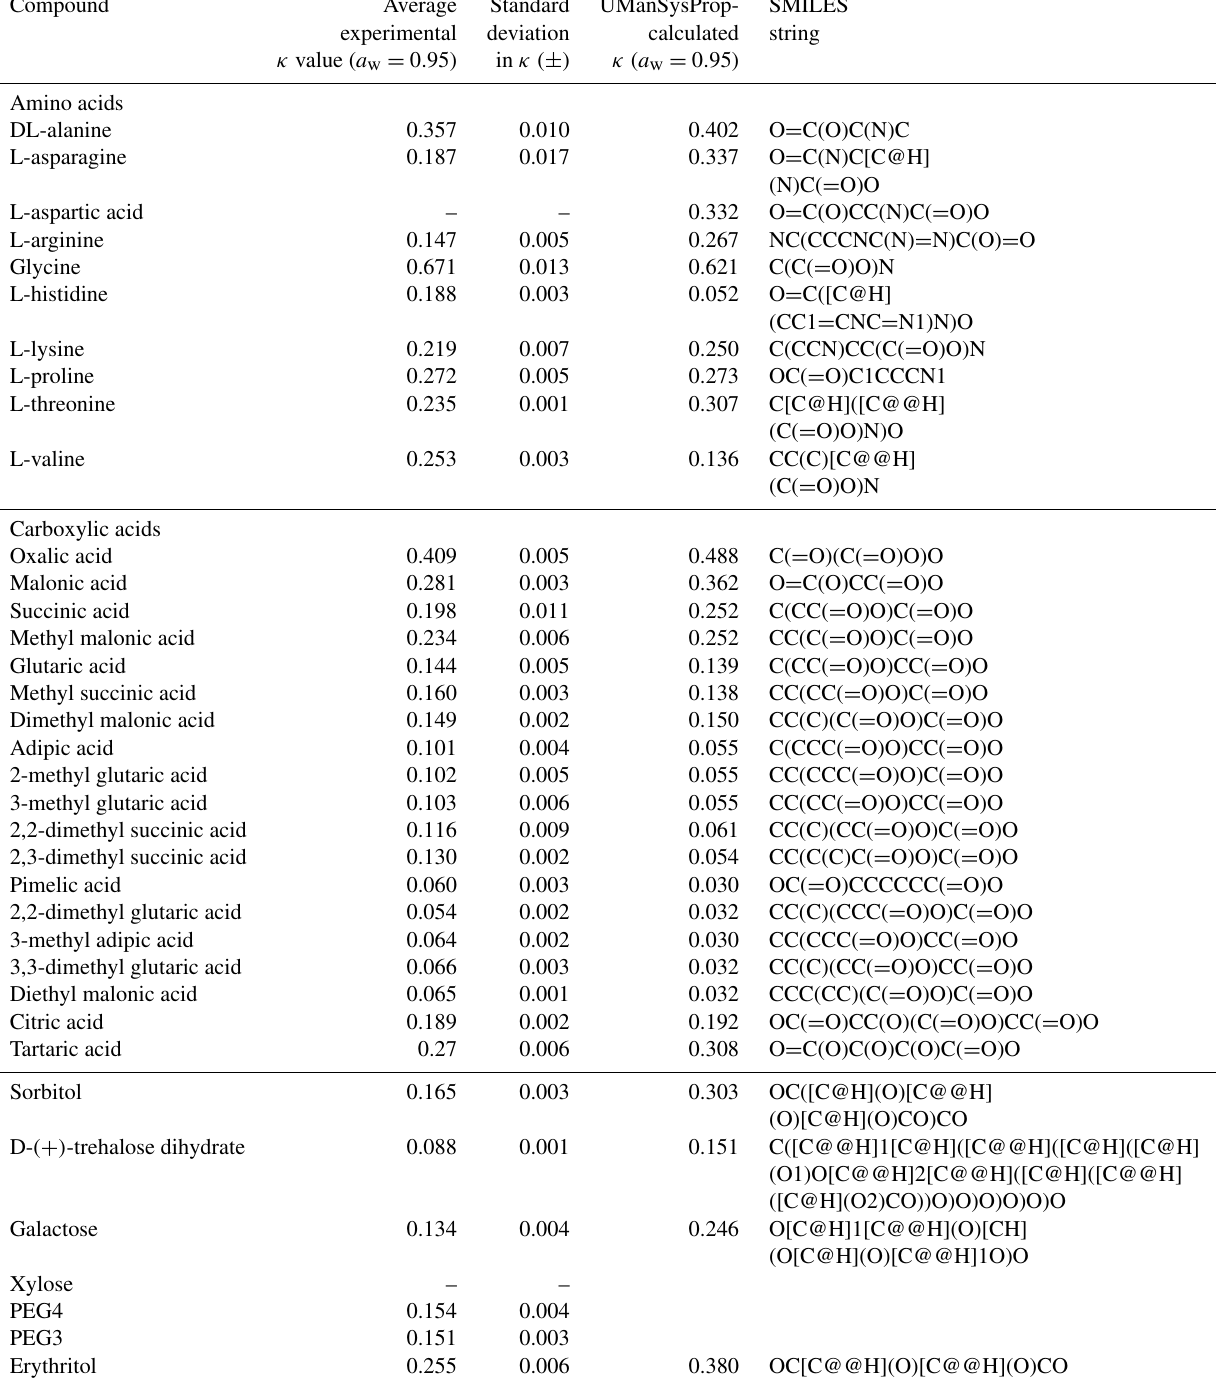
Table 1. Experimentally determined κ values at a w = 0 . 95 for all compounds studied at 293.15K, presented alongside κ values calculated using UManSysProp and the SMILES string used for this